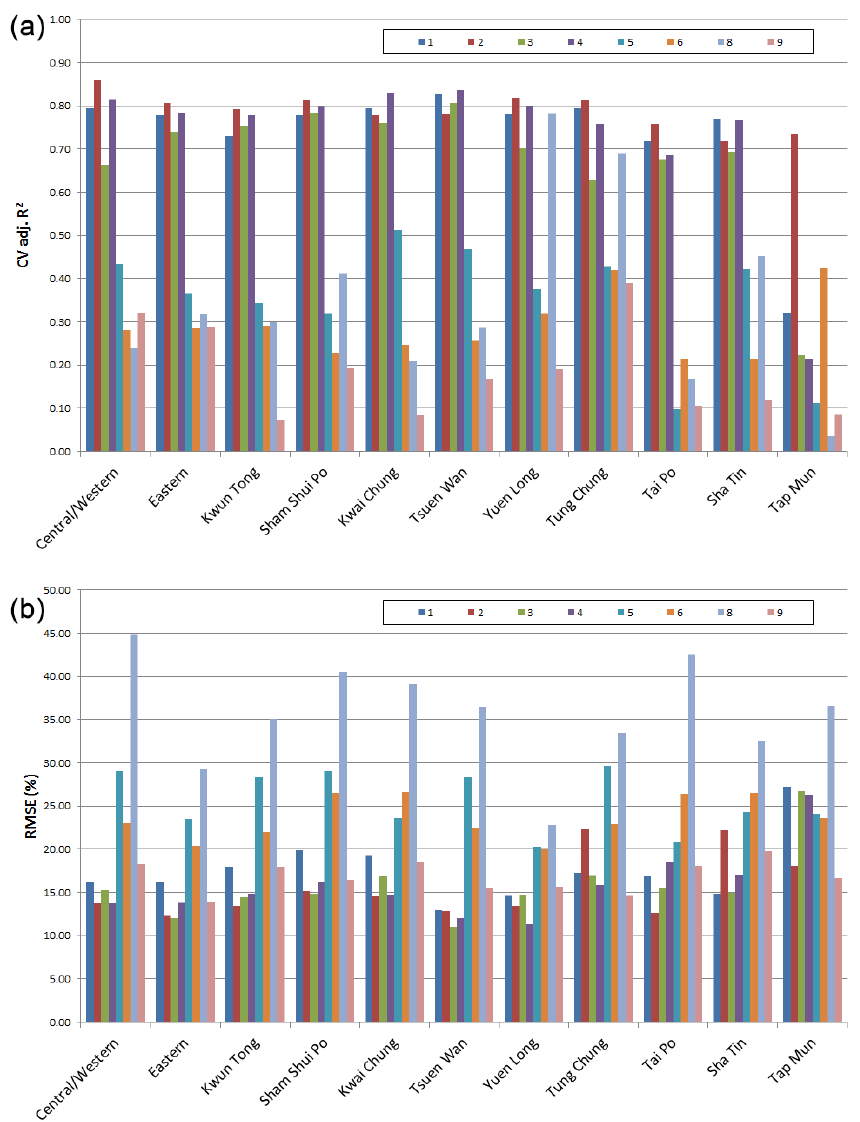
Figure 5. The CV-adjusted R 2 and RMSE for each of the HK-AQN stations used in this work, as reported by the models listed in Table